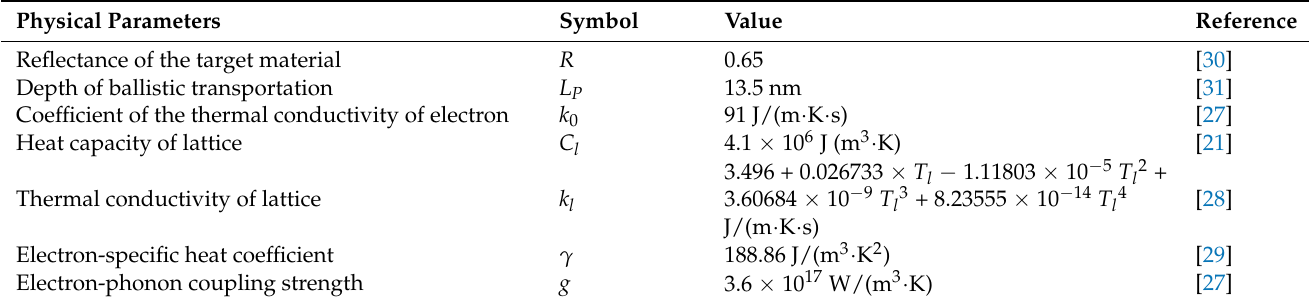
Table 1. Physical parameters of the target material.